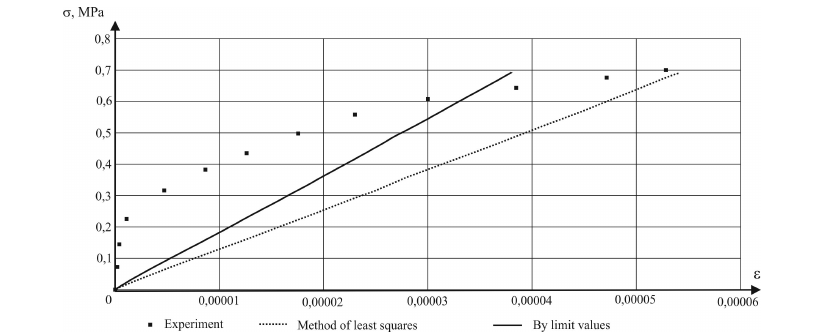
Figure 4. A tension diagram of concrete grade